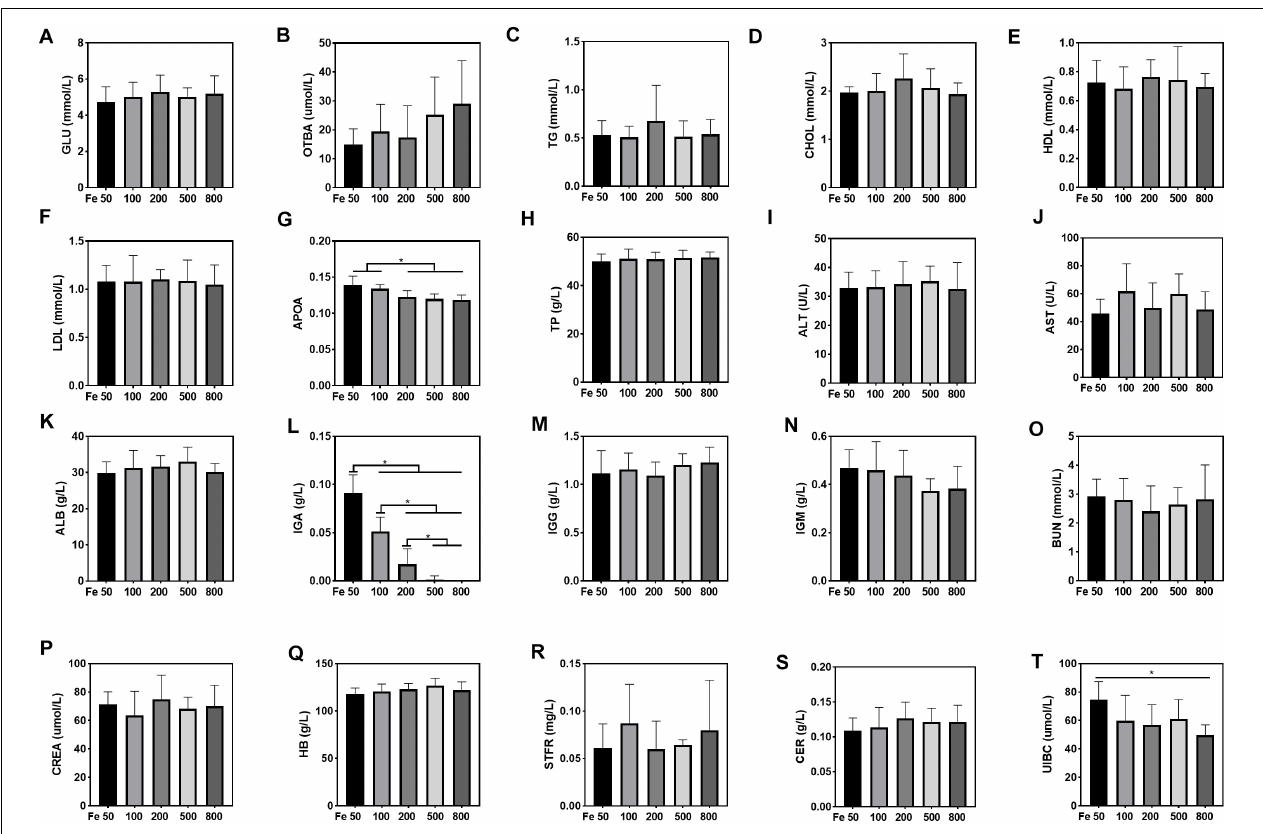
FIGURE 3 | Dietary iron downregulated serum unsaturated iron-binding capacity (UIBC), apolipoprotein (APOA), and immunoglobin A (IGA). Serum glucose (GLU), total bile acids (OTBAs), triglyceride (TG), CHOL, high-density lipoprotein (HDL), low- density lipoprotein (LDL), total protein (TP), alanine aminotransferase (ALT), aspartate amino transferase (AST), albumin (ALB), IgG, and IgM were the same among all the groups (A–F,H–K,M,N) . Serum APOA (G) and IgA (L) were downregulated with dietary iron increasing. Blood HB and serum soluble transferrin receptor (STFR) and ceruloplasmin (CER) were similar among all the groups (Q–S) . Serum UIBC (T) went down from the Fe50 to Fe800 groups, and UIBC in the Fe50 group was higher than in the Fe800 group. Serum BUN (O) and CREA (P) were also similar among all the groups. Ordinary one-way ANOVA or Kruskal–Wallis test was used for the statistical analysis among different groups. Data were presented as mean ± SD. * P < 0.05. TABLE 1 | Alpha diversity indices of the colonic microbiota of piglets. Fe50 Fe100 Fe200 Fe500 Fe800 SEM P